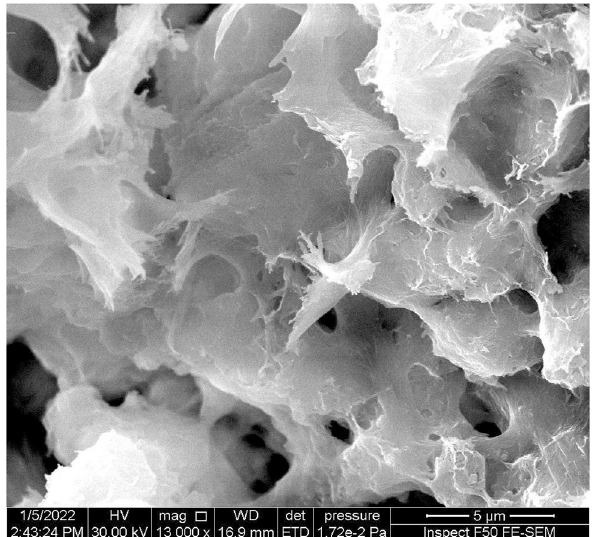
Figure 5: FESEM of sample A8 porcelanite concrete magni fi ed 13,000 ×